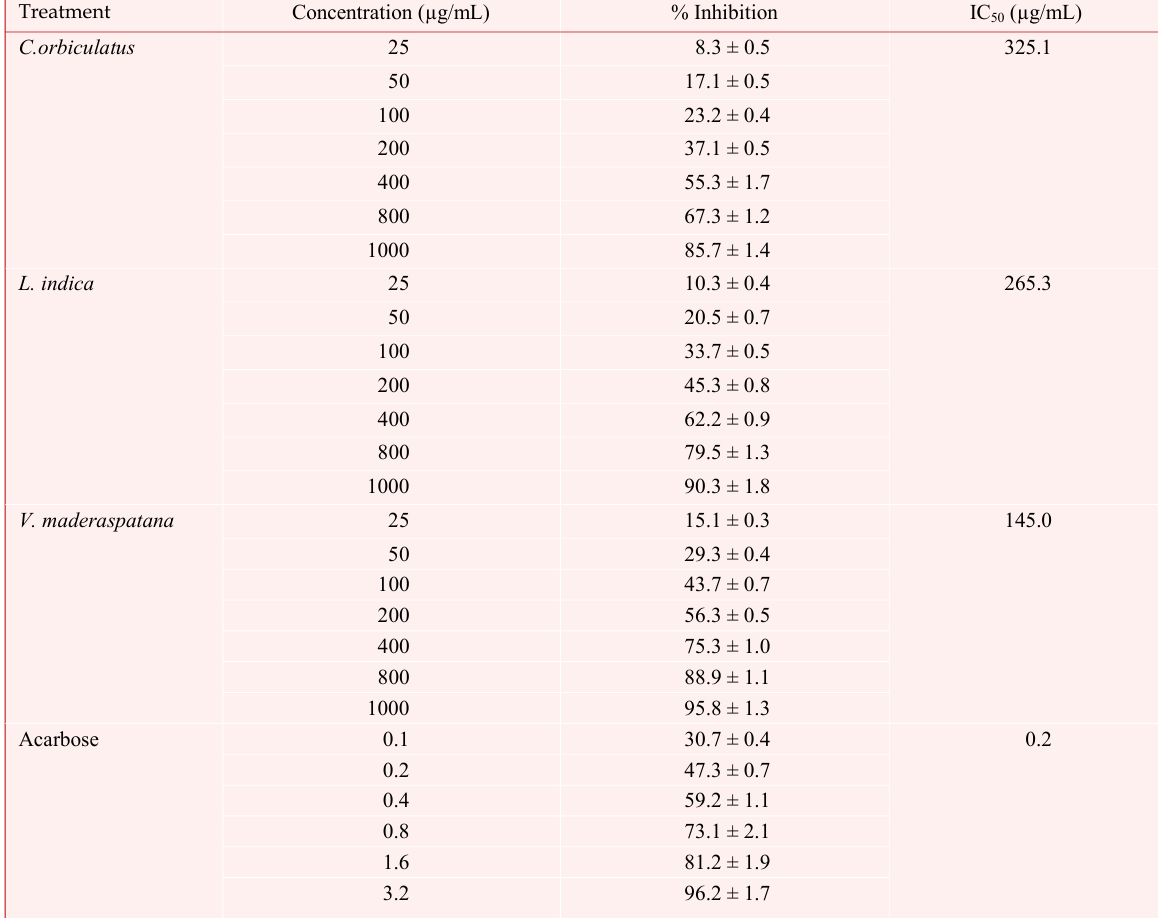
Effect of C. orbiculatus, L. indica and V. maderaspatana on inhibiton of α - glucosidase enzyme